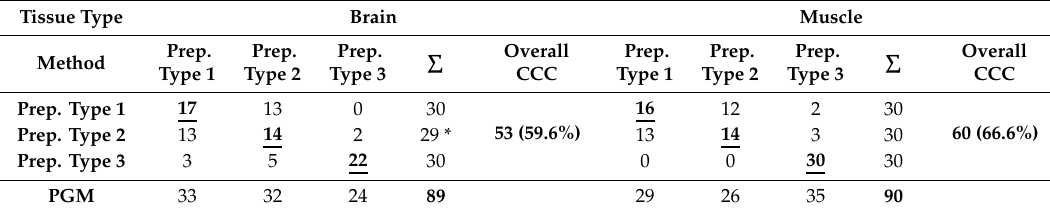
Table 3. Classification results of the spectral datasets derived from brain and muscle tissue samples